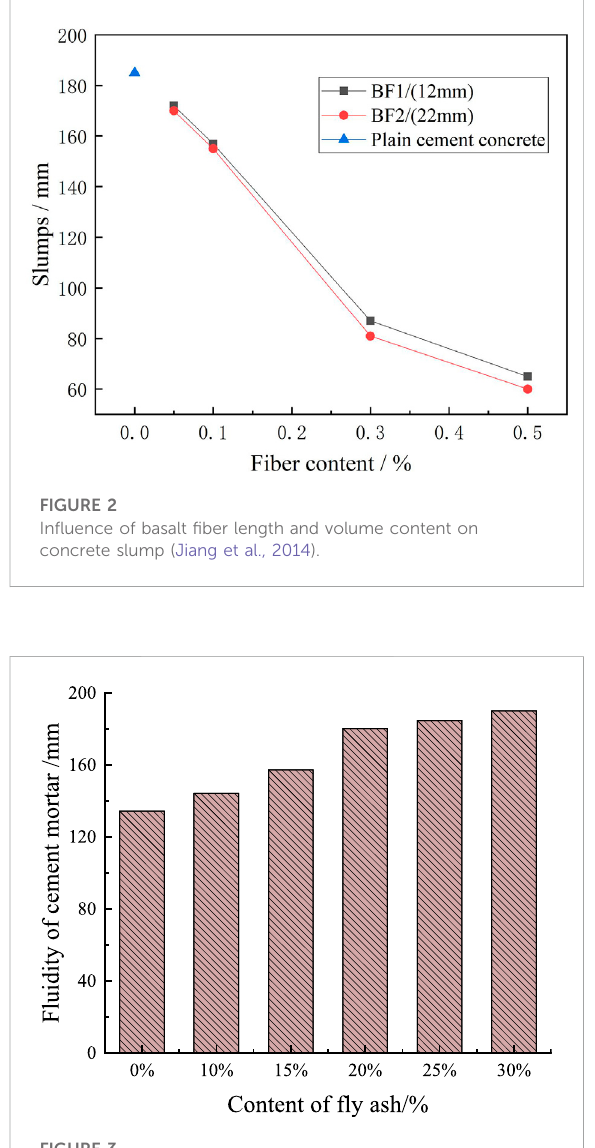
FIGURE 3 The effect of fl y ash on the fl uidity of BFRC (He et al.,